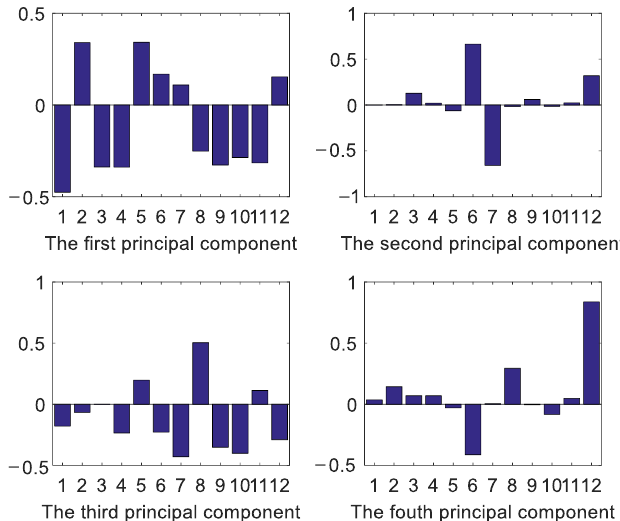
Figure 6. The linear combination coefficients for first four principal components (The number on the x-axis coordinate corresponds to the serial number in Table 2).